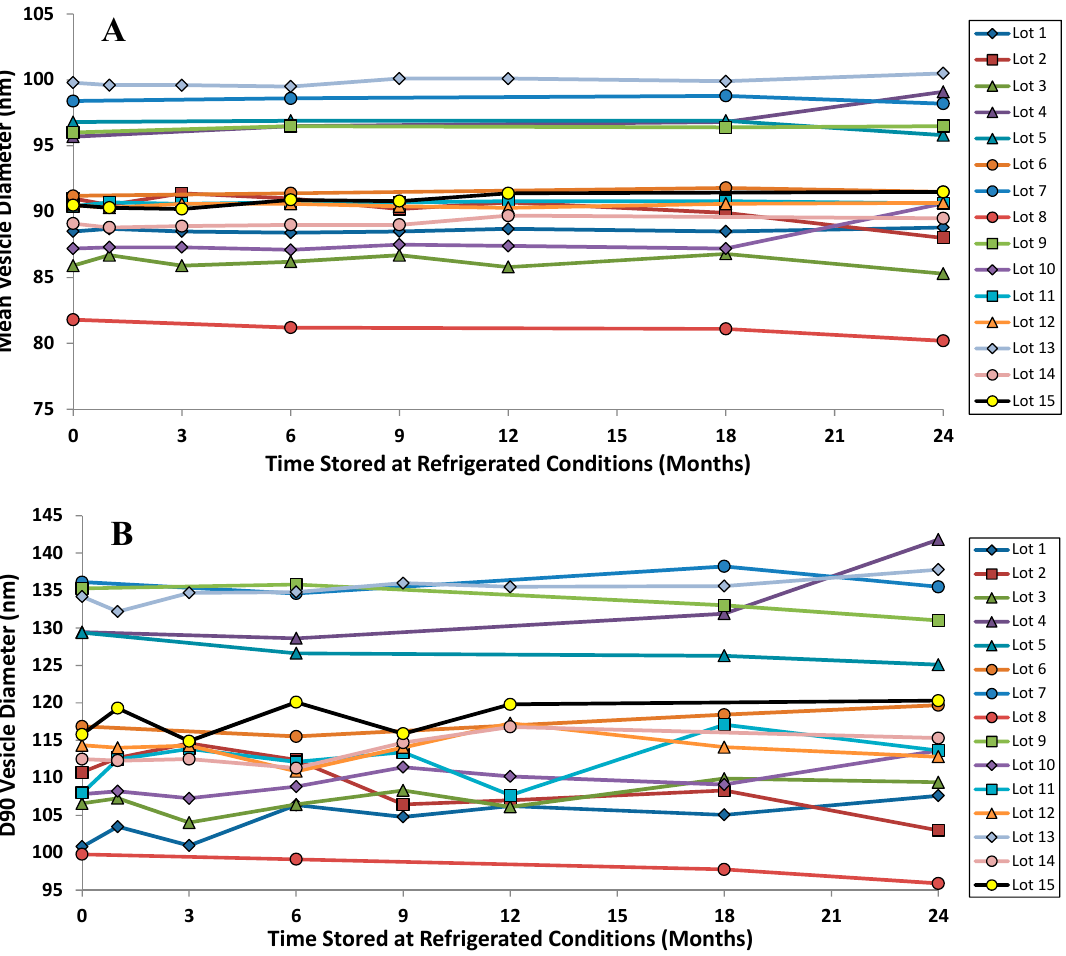
Figure 8. The vesicle size distribution on stability for the first 15 GMP lots of Lipoquin. There was no change in ( A ) the mean vesicle size and ( B ) the D90 size after refrigerated storage for 24 months. Adapted with permission from references [41,42]. Copyright 2013 RDD online.